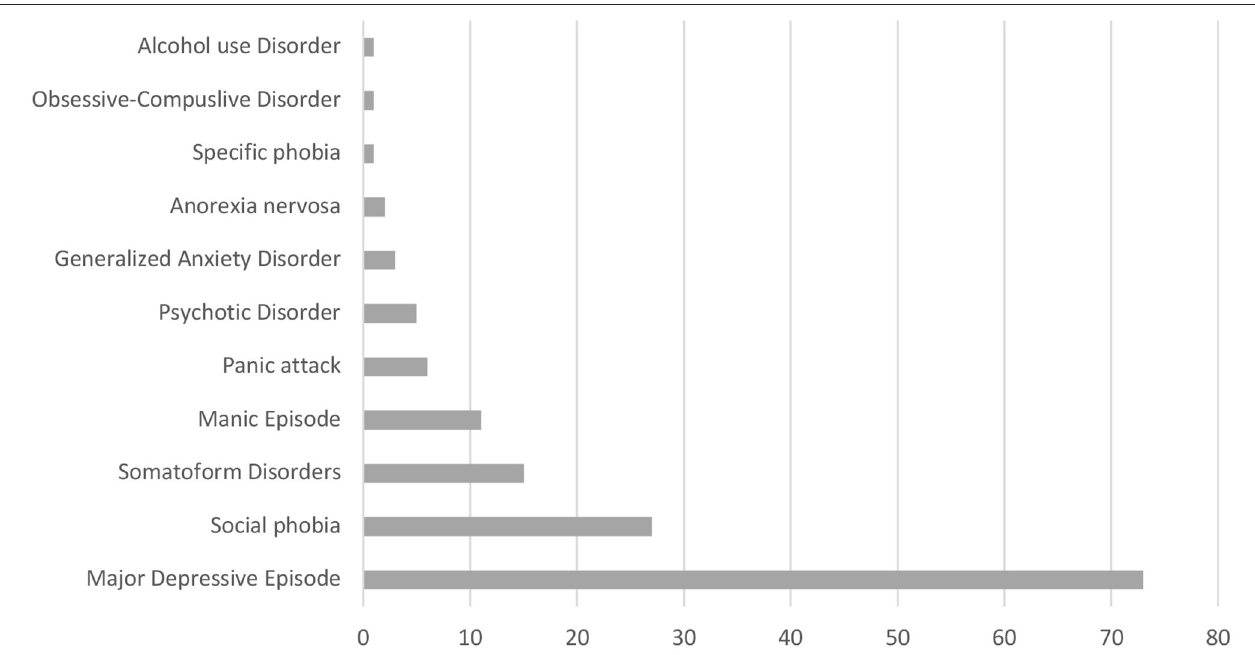
FIGURE 1 | Frequency of psychiatric diagnosis based on DSM-IV.